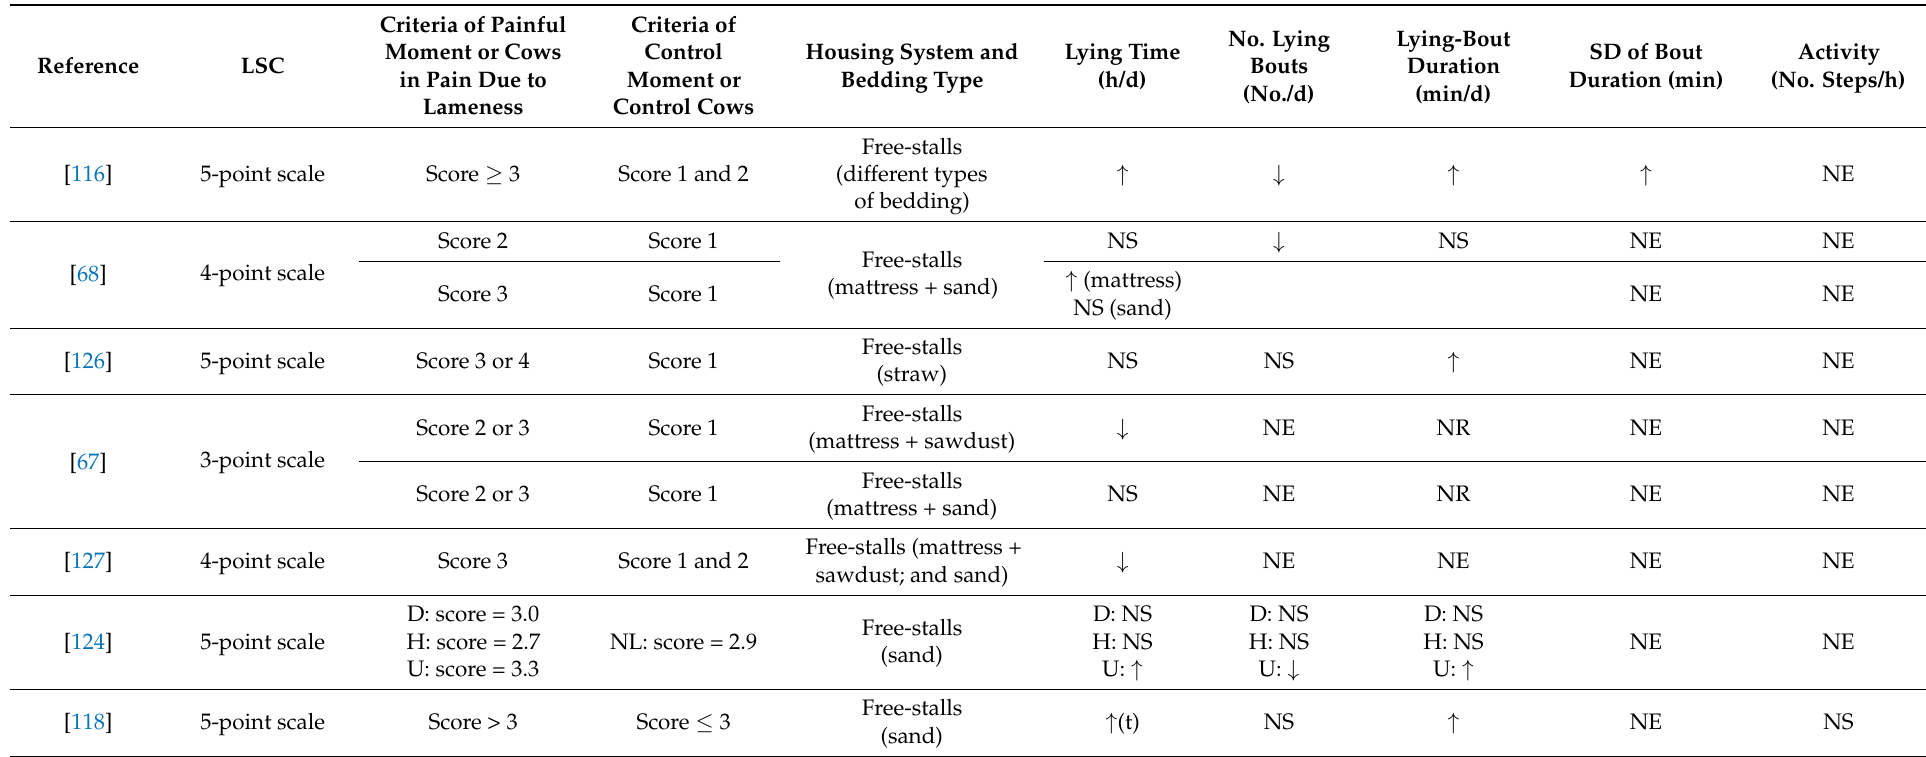
Table 2. Summary of changes in activity patterns in cows (lying time, number of lying bouts, lying bout duration, standard deviation of bout duration and activity) caused by lameness. Studies are summarised by comparing cows with lameness to the control (including degree of severity). Lameness assessment score (from 1 = non-lame to 3 or 5 = severely lame) and housing system and bedding type are documented. Type of change ( ↑ increase; ↓ decrease; NS =